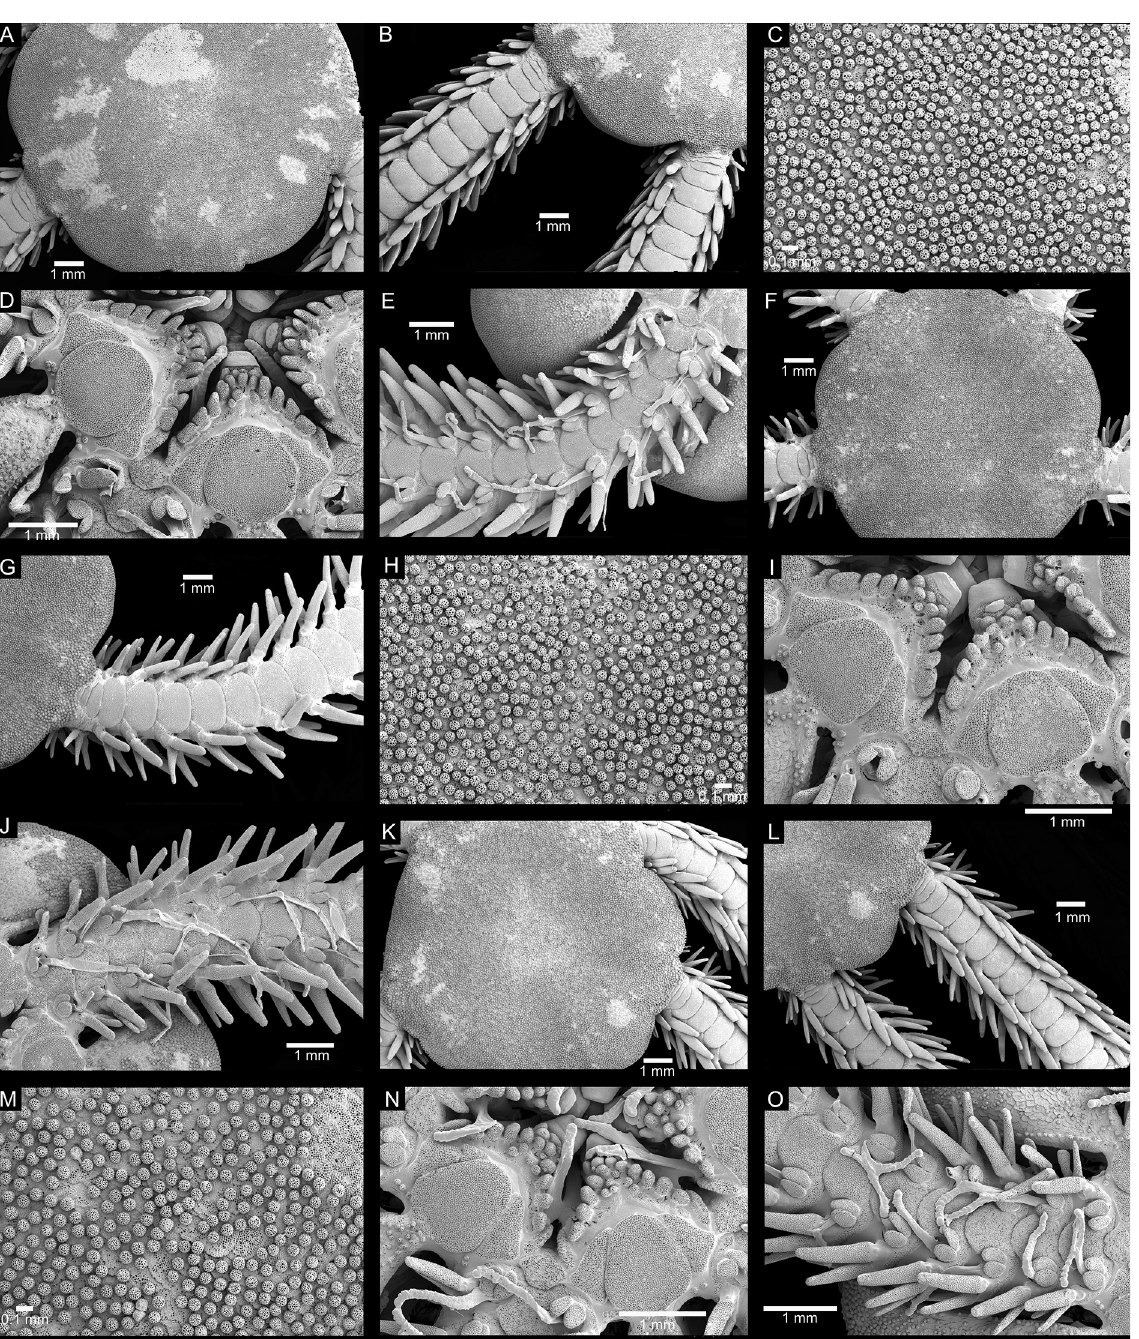
Fig. 4. SEM images of three species of Ophiocoma ( Breviturma ) subgen. nov. A-E . Ophiocoma brevipes Peters, 1851 (SMNH-133230). A . Dorsal disc. B . Dorsal arms. C . Dorsal disc granules. D . Jaws. E . Ventral arm. F-I . Ophiocoma dentata Müller & Troschel, 1842 (SMNH-133232). F . Dorsal disc. G . Dorsal arm. H . Dorsal disc granules. I . Jaws. J . Ventral arm. K-N . Ophiocoma krohi sp. nov. paratype (SMNH-Type-8534). K . Dorsal disc. L . Dorsal arms. M . Dorsal disc granules. N . Jaws. O. Ventral arm. For institution codes see main